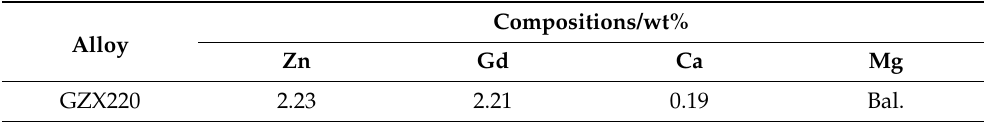
Table 1. XRF results of the as-cast